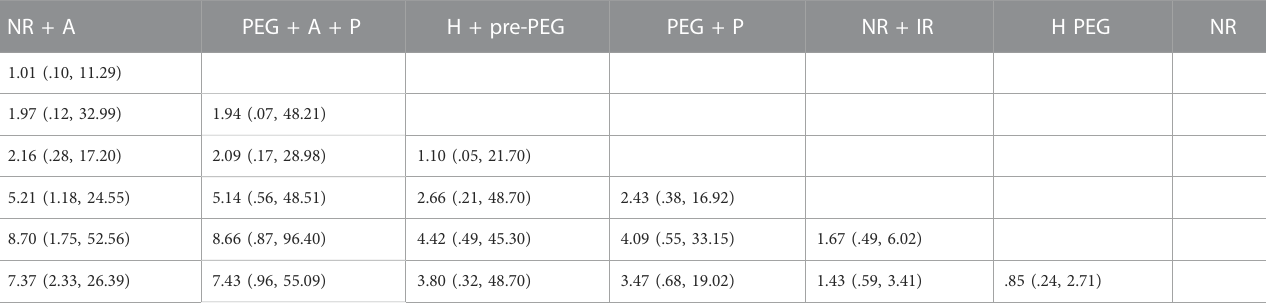
TABLE 2 Network meta-analysis of adequate bowel preparation.